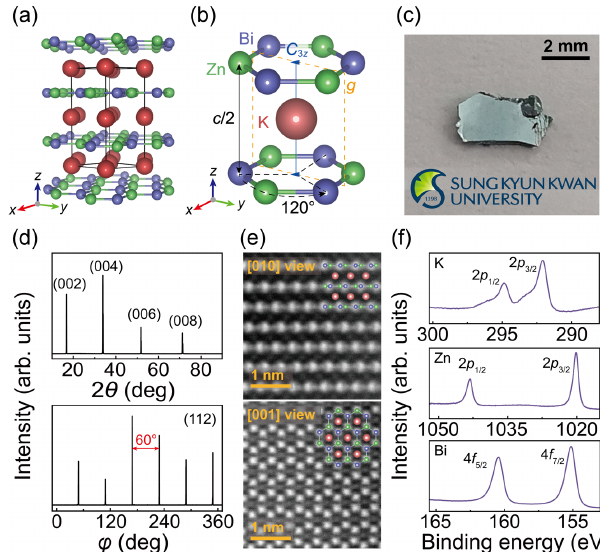
FIG. 1. Crystal structure of KZnBi. (a),(b) Atomic structure of KZnBi, which belongs to the P 6 3 =mmc space group (a). The solid lines represent a conventional hexagonal unit cell. The Zn (green) and Bi (purple) ions form honeycomb layers with an AB stacking order while the K ion is located at the inversion center. The plane indicated by orange dashed lines ( g ) denotes the glide mirror plane and the blue solid line shows the principal axis of the threefold rotation symmetry ( C 3 ) (b). (c) Image of high-quality z KZnBi single crystal with a few millimeters size. (d) Single- crystal XRD patterns for the family of ( 00 l ) peaks (top) and periodic reflections of (112) plane (bottom). (e) High-angle annular dark-field (HAADF)-STEM images taken along [010] (top) and [001] (bottom) zone axes. (f) XPS spectra of K 2 p (top), Zn 2 p (middle), and Bi 4 f (bottom)